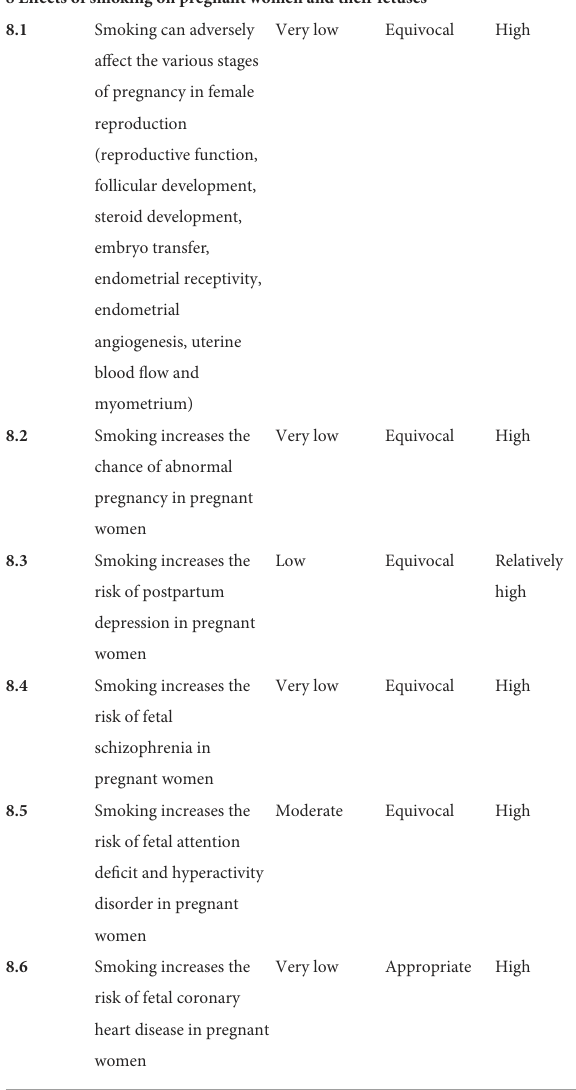
TABLE 4 Effects of smoking on pregnant women and their fetuses. TABLE 5 The correlation between smoking and risks of female diabetes, rheumatoid arthritis and respiratory